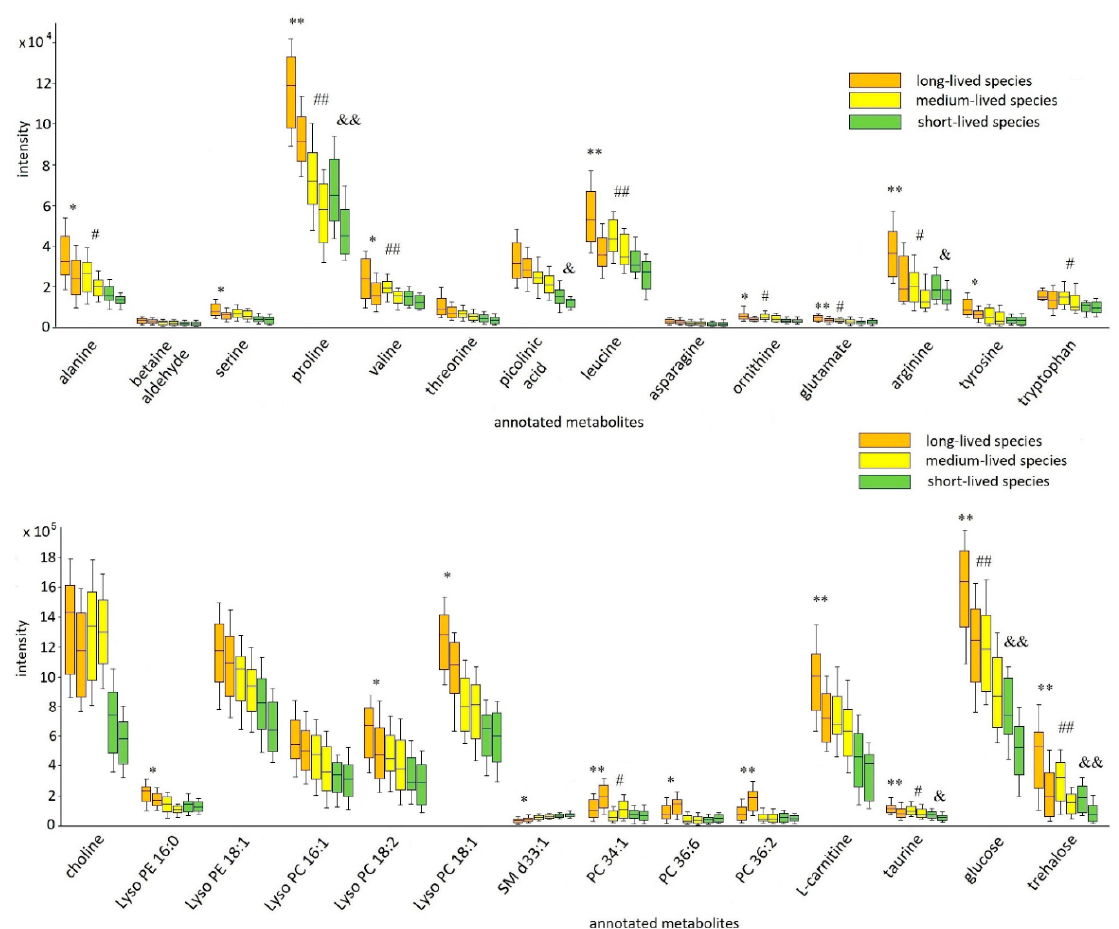
Figure 4. Box plot graphs of the age-related drift of selected metabolites within every fly cohort. The box-whisker plot presents the distribution of normalized intensity values of the annotated metabolites. Each cohort is represented by two boxes of the same background color. The first box (left box) is the young subgroup, and the second box (right box) is the mature subgroup. The top and bottom of the boxes represent the 25% and 75% percentiles; the 5% and 95% percentiles are indicated as error bars. The median value is indicated by horizontal lines within each box. In addition, the results of the pairwise comparisons of the metabolite levels between the two subgroups in each cohort are displayed (Table S2). The pairwise differences were calculated by the Mann–Whitney U test (* p ≤ 0.05 (** p ≤ 0.01), significant change between subgroups (young vs. mature) of long-lived species; # p ≤ 0.05 ( ## p ≤ 0.01), significant change between subgroups (young vs. mature) of medium species; & p ≤ 0.05 ( && p ≤ 0.01), significant change between subgroups (young vs. mature) of short-lived species).